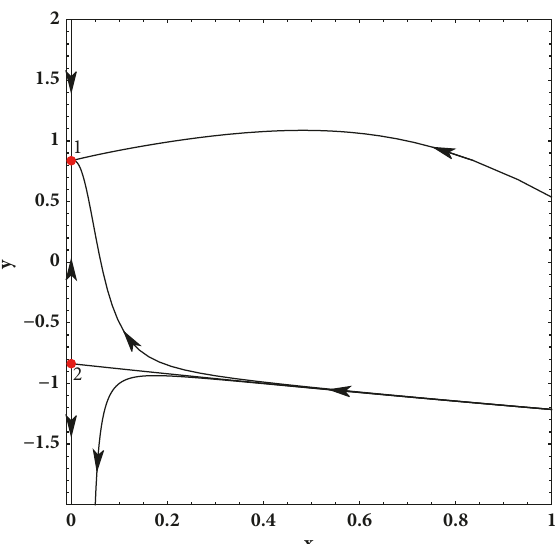
Figure 1: The phase portrait of system (39). Critical point 1 (𝑥 = /√3𝐻 0,𝑦 = √Λ ) is the stable node and critical point 2 (𝑥 = bare 0 /√3𝐻 0,𝑦 = −√Λ ) is the saddle. These critical points represent bare 0 the de Sitter universes. Here, 𝐻 0 is the present value of the Hubble function. The value of 𝐴 is assumed as −𝐻 0 . Note that the phase portrait is not symmetric under reflection 𝐻 󳨀→ −𝐻 . While critical point 1 is a global attractor, only a unique separatrix reaches critical point